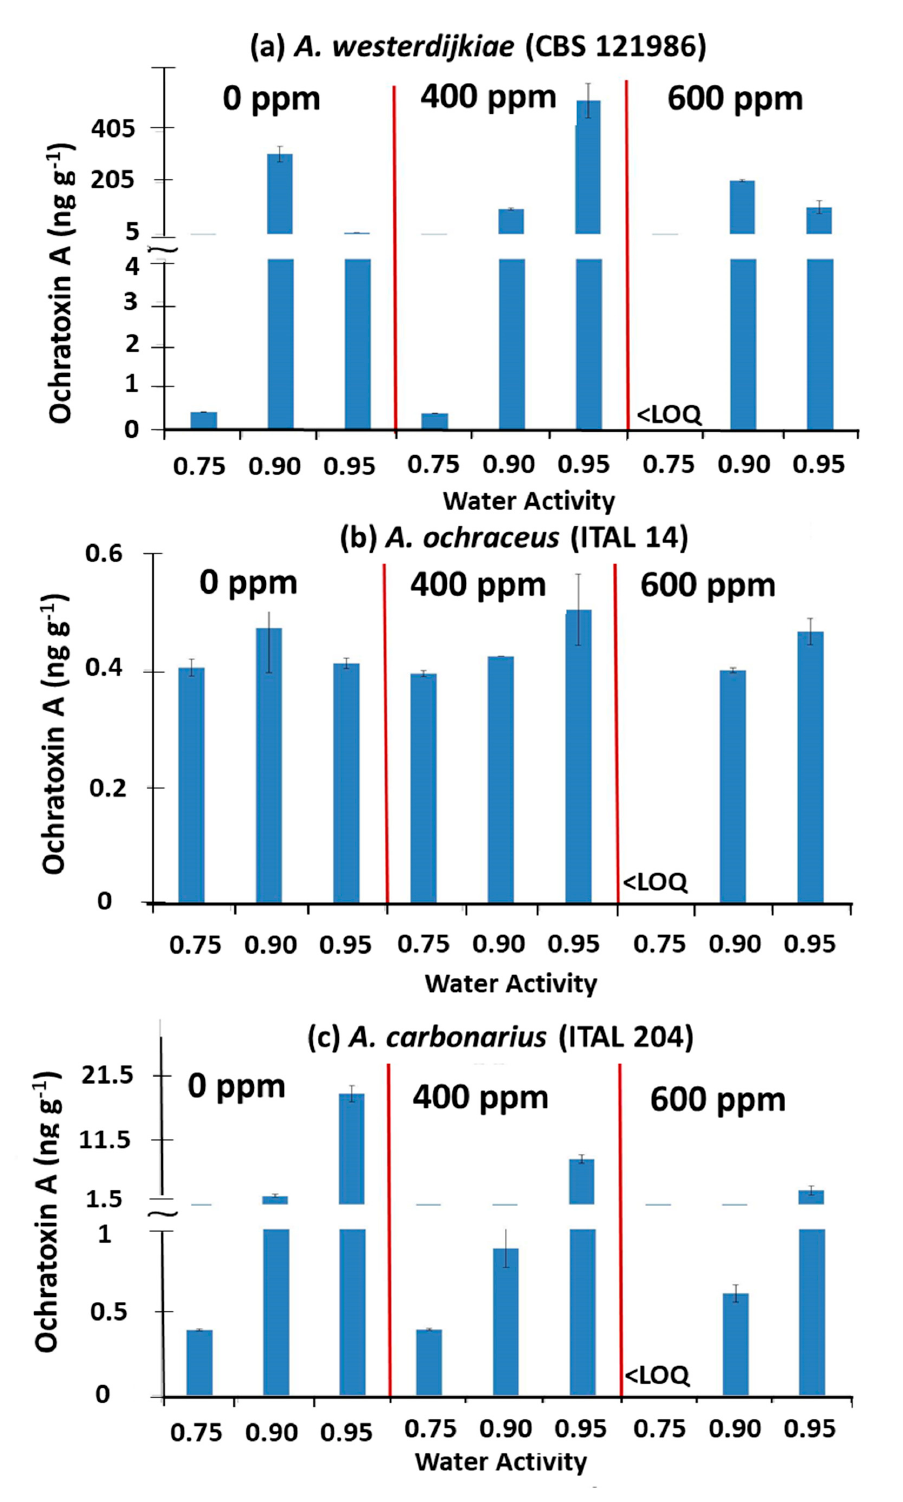
Figure 2. Combined effect of O 3 dose and a w (0.75, 0.90, 0.95 a w ) on ochratoxin A production in coffee beans inoculated with ( a ) A. westerdijkiae , ( b ) A. ochraceus , and ( c ) A. carbonarius and treated with O 3 (400, 600 ppm; 6 L min − 1 , 60 min) and stored at 30 ◦ C for 12 days. Vertical bars indicate the standard error of the means. Key: < LOQ. Less than Limit of